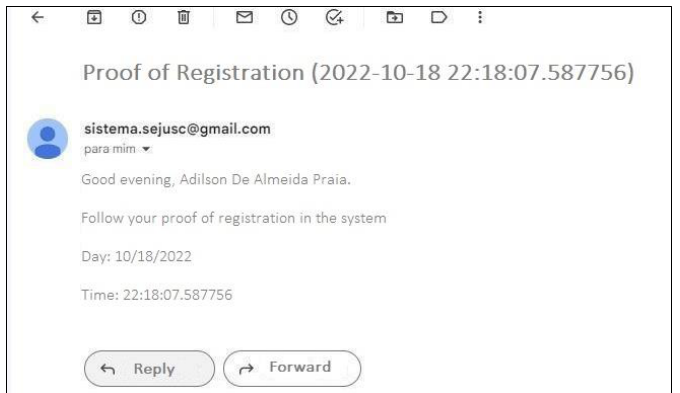
Figure 31: Proof of Registration via E-mail.